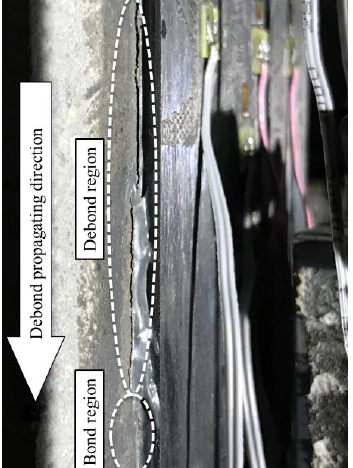
Figure 8. Debond propagation under fatigue load.